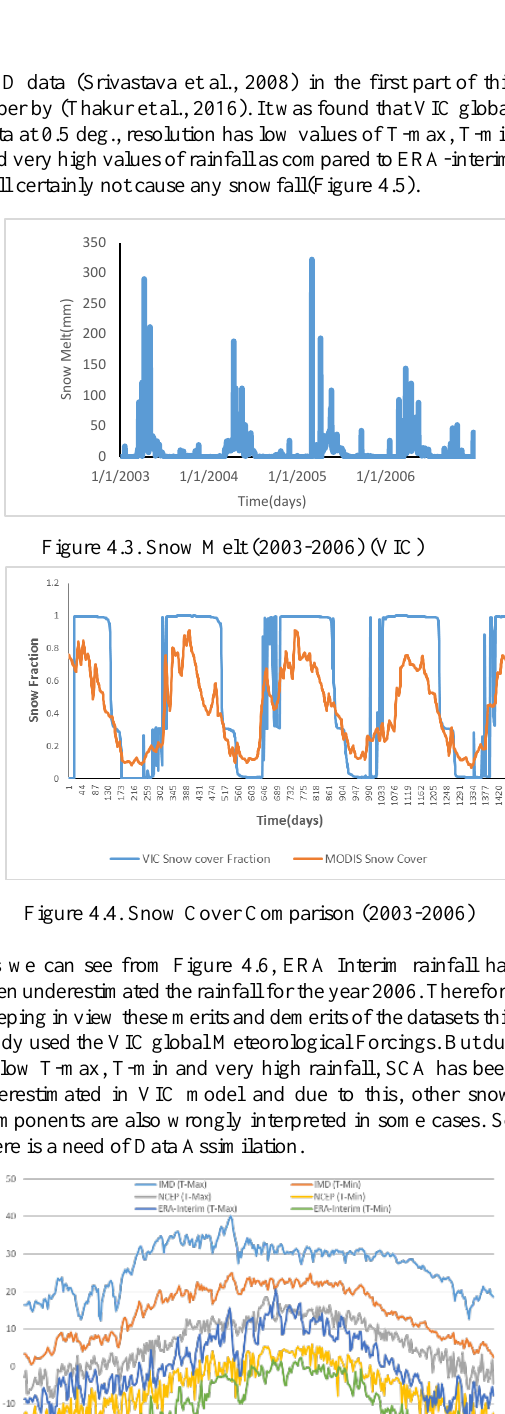
Figure 4.2. Snow Water Equivalent (2003-2006) (VIC)